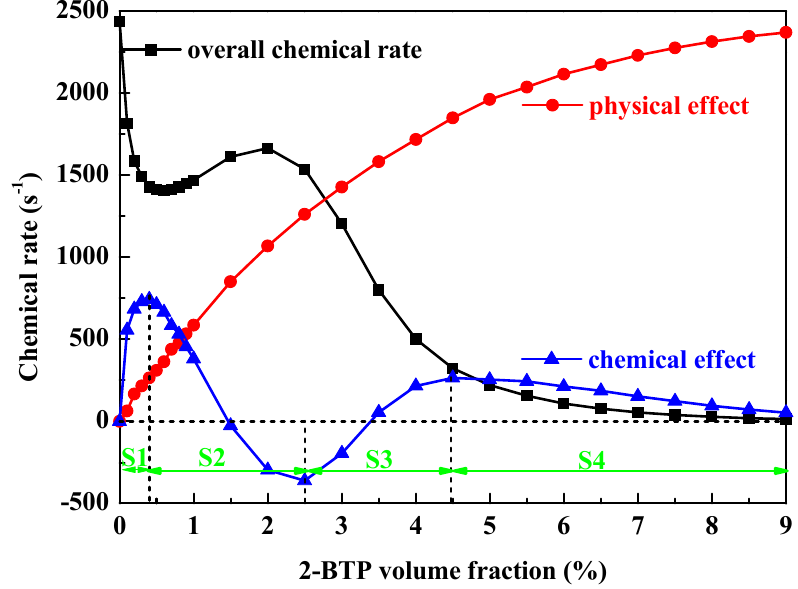
Figure 4. The overall chemical rate/chemical effect/physical effect as a function of 2-BTP volume fraction in Φ = 0.6 moist C 3 H 8 /air flames at 298 K and 1 bar.